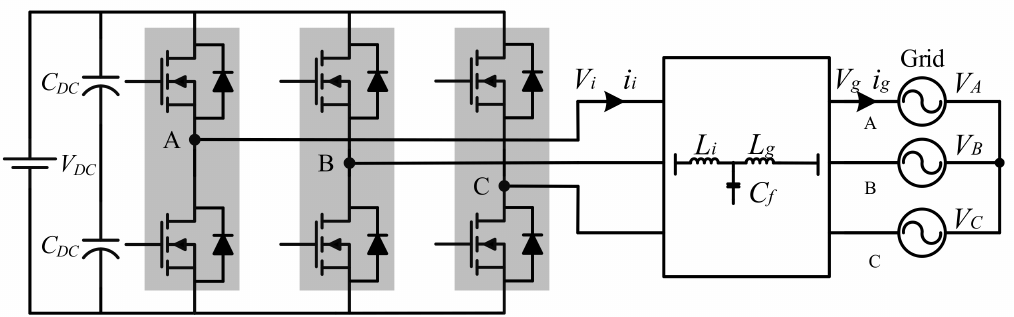
Figure 2. Grid-connected